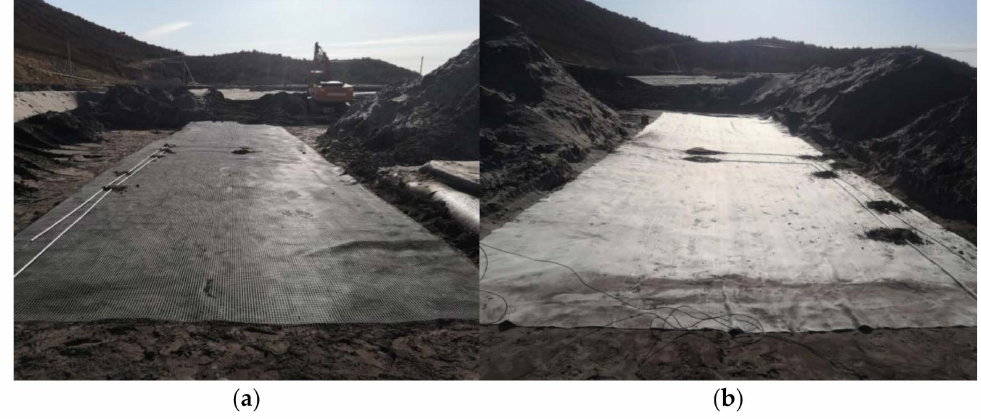
Figure 4. Laying of reinforcement materials for the reinforced dam: ( a ) geogrid; ( b ) geotextile.